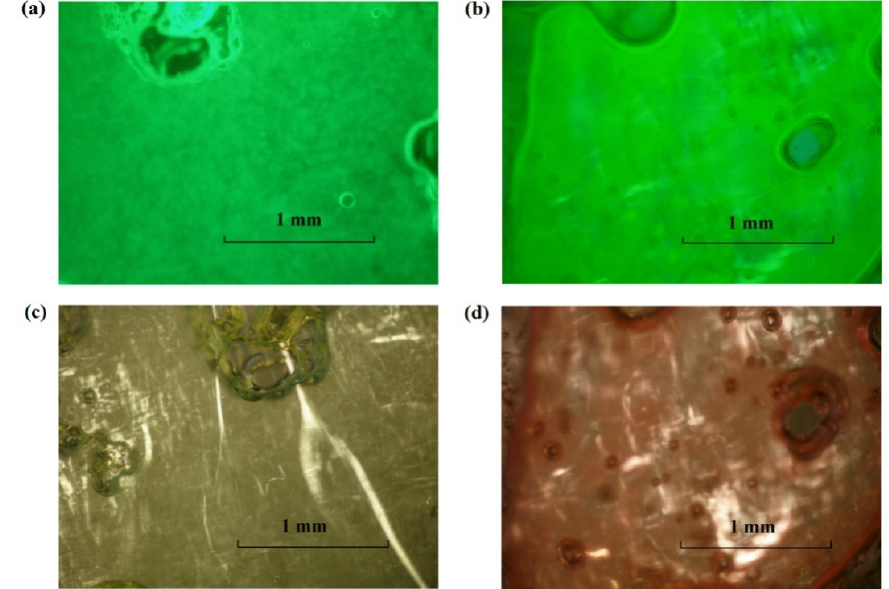
Figure 5. Fluorescence image of lecithin-linker MBG (20% gelatin) with 10% SMO labelled with ( a ) Sodium Fluorescein and ( b ) Nile Red. Cross-polarized light images of lecithin-linker MBG of ( c ) the sample of panel ( a ) and ( d ) the sample of panel ( b ). For formulation details see Figure 1 and Table